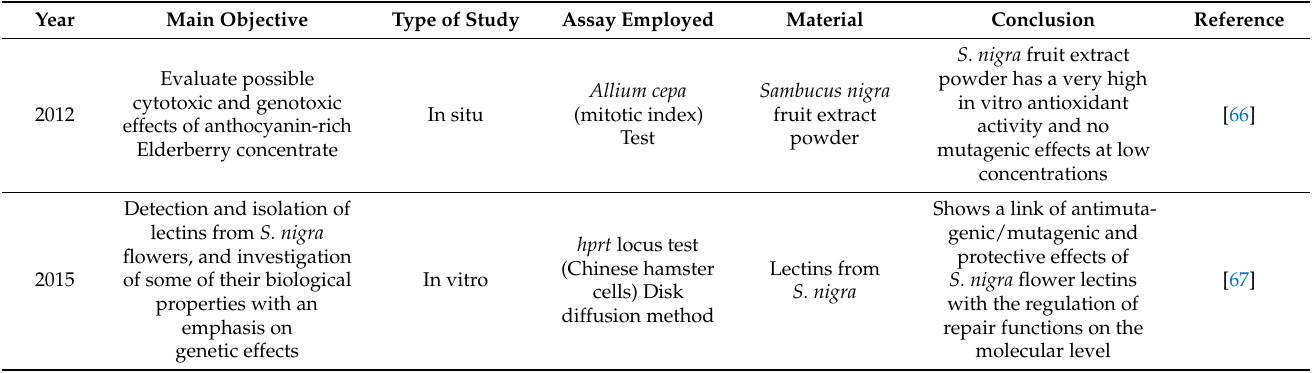
Table 2. Relevant studies of